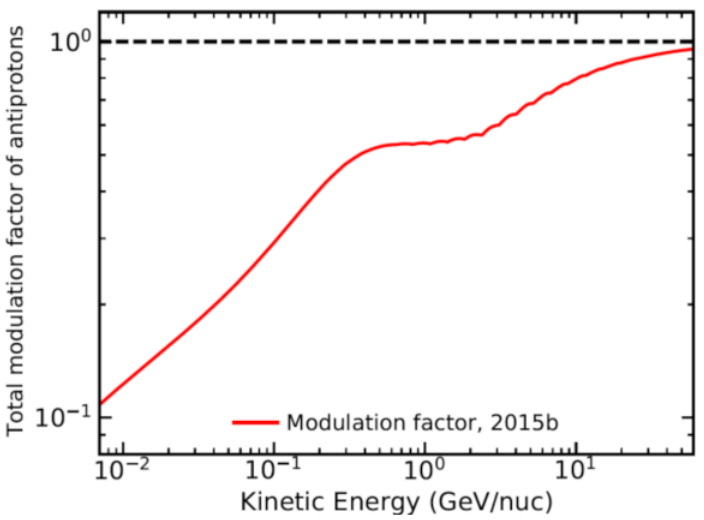
Figure 18. The total modulation factor for anti-protons as a function of KE at Earth with respect to the normalized VLIS specified at 122 AU; here computed for the period